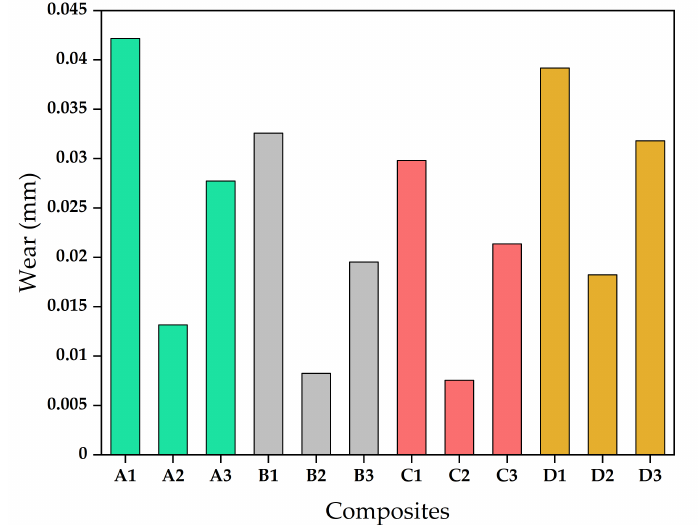
Figure 5. Wear behaviour of